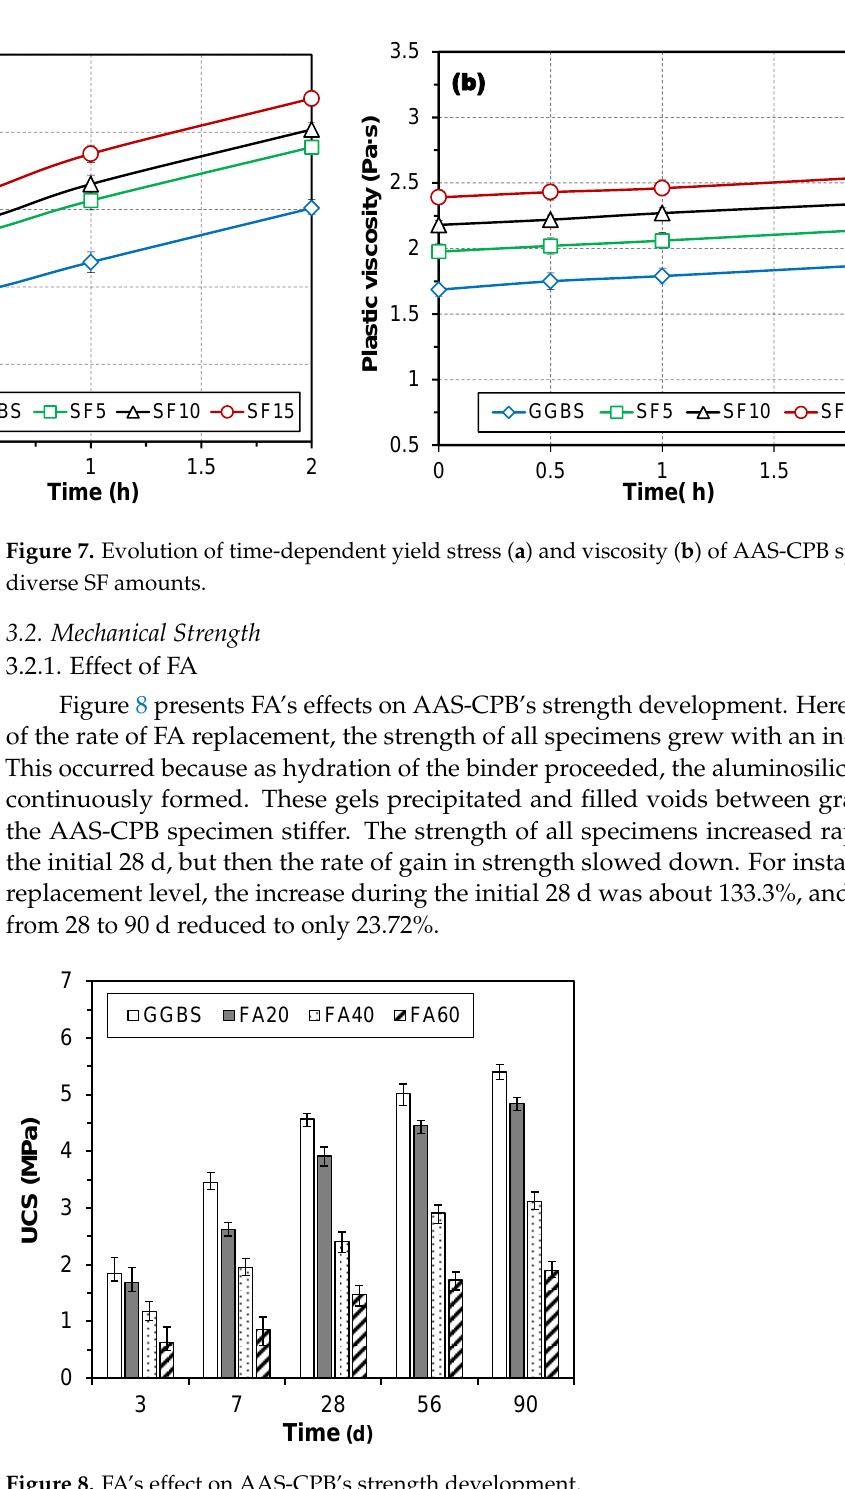
Figure 9. TG/DTG of GGBS, FA20, FA40, and FA60 pastes at 28 d. 3.2.2. Effect of MK Figure 10 presents MK ’s effect on strength increases of AAS-CPB. Substituting GGBS with MK produced a positive or negative impact on AAS- CPB’s strength based on the rate of replacement and age. The addition of MK at low (5%) and medium (15%) levels slightly improved AAS- CPB’s strength up to 56 days, and higher MK contents were associated with greater improvements in strength. This is because finer MK particles can fill the void within the AAS-CPB matrix and, therefore, make the microstructure denser. In addition, aluminum- and silica-rich MK reacts relatively rapidly in an alkaline environment and generates C(N)-A-S-H gels with higher Si/Ca and Al/Ca ratios [62 – 66].